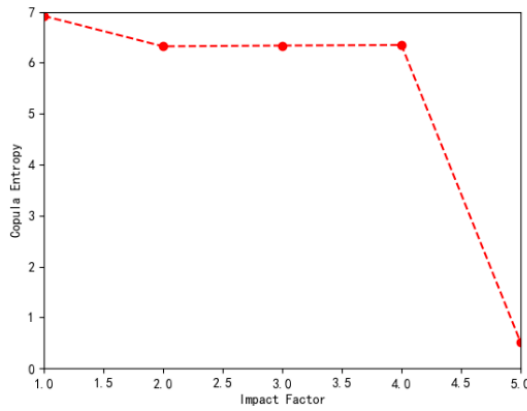
Figure 3. CE of each pollutant factor and PM2.5.